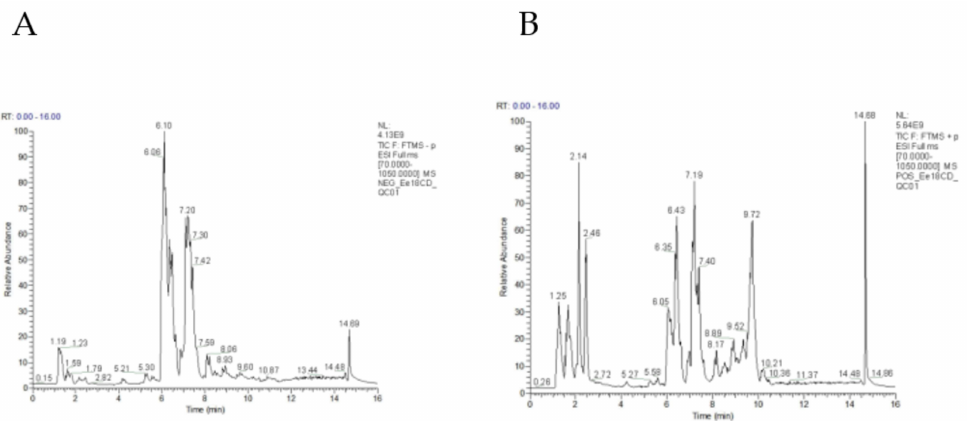
Figure 1. Total ion chromatogram of quality control sample in positive ( A ) and negative ( B ) ion